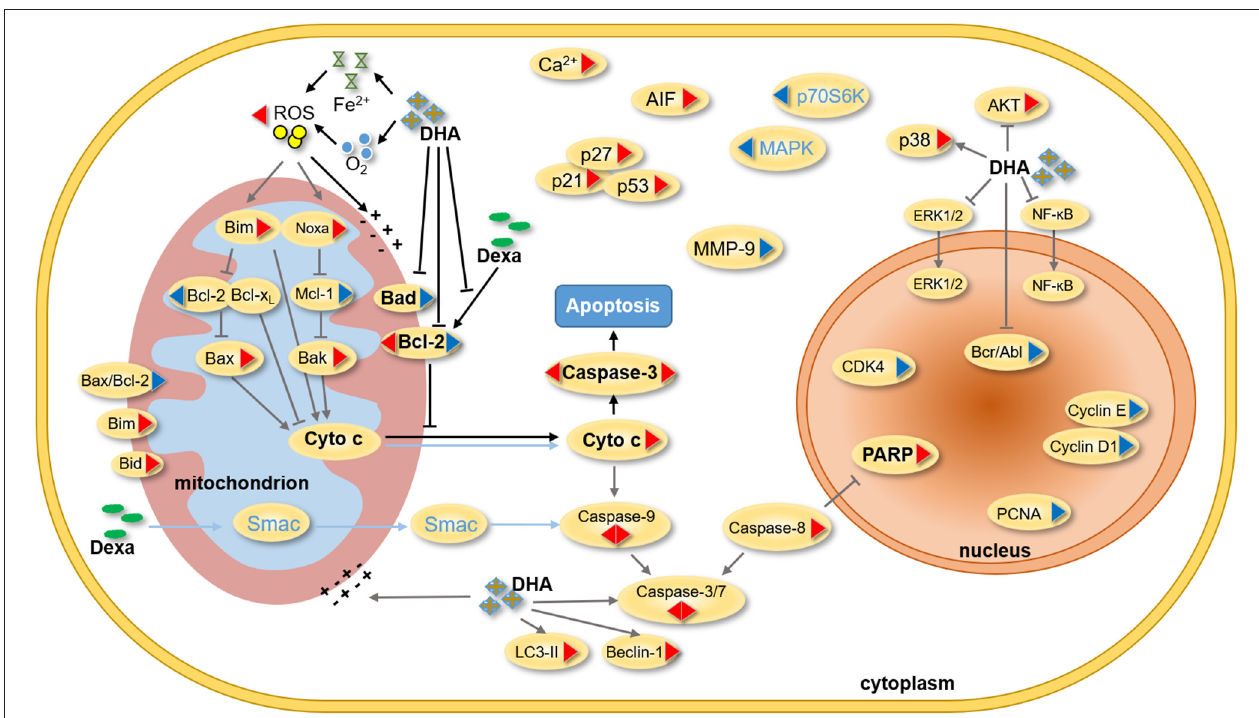
FIGURE 7 | Summary of the effect of DHA and Dexa on MM. In previous studies, DHA was found to influence the progression of different cancers by regulating the expression of mitochondrial, nucleus and cytoplasmic proteins. On protein level, Dexa inhibits the proliferation of MM cells by mainly adjusting the expression of Smac, cytochrome C, caspase-3, caspase-9, MAPK and p70S6K. In our study, DHA was found to not only induce the mitochondrial apoptosis pathway, but also inhibit Bcl-2 expression induced by Dexa. A synergism of DHA and Dexa increases ROS levels and translocation of cytochrome C from mitochondria to the cytoplasm, and then alters mitochondrial membrane potential as well as caspase-mediated apoptosis. (The triangle on the left shows the effect of Dexa on the protein expression, and the other side shows the effect of DHA on the protein expression. The red triangle indicates an increase in protein expression and the blue triangle indicates a decrease in the protein expression. The blue characters and lines represent Dexa-acting proteins. The black line and the bold characters represent the summary of this study, and the gray line represents the summary of the literature